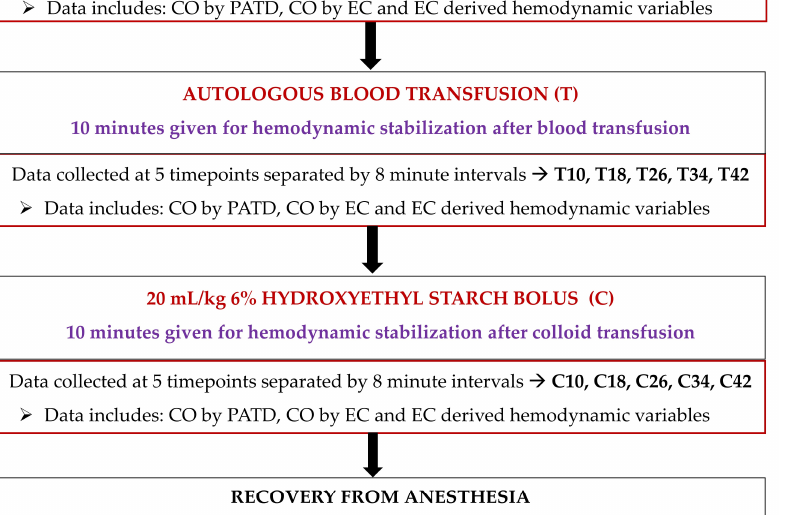
Figure 3. Timeline of the study design and data collection in six, healthy, adult isoflurane-anesthetized Beagle dogs. After anesthetic induction and instrumentation, data were collected: (1) at the baseline; (2) after 33% blood volume loss (H); (3) after the autologous blood transfusion (T); and (4) after the infusion of 20 mL/kg 6% Hydroxyethyl Starch 130/0.4 in 0.9% sodium chloride solution (C). A 10 min hemodynamic stabilization period was provided between the manipulation of blood volume during H, T, and C, and before data collection.